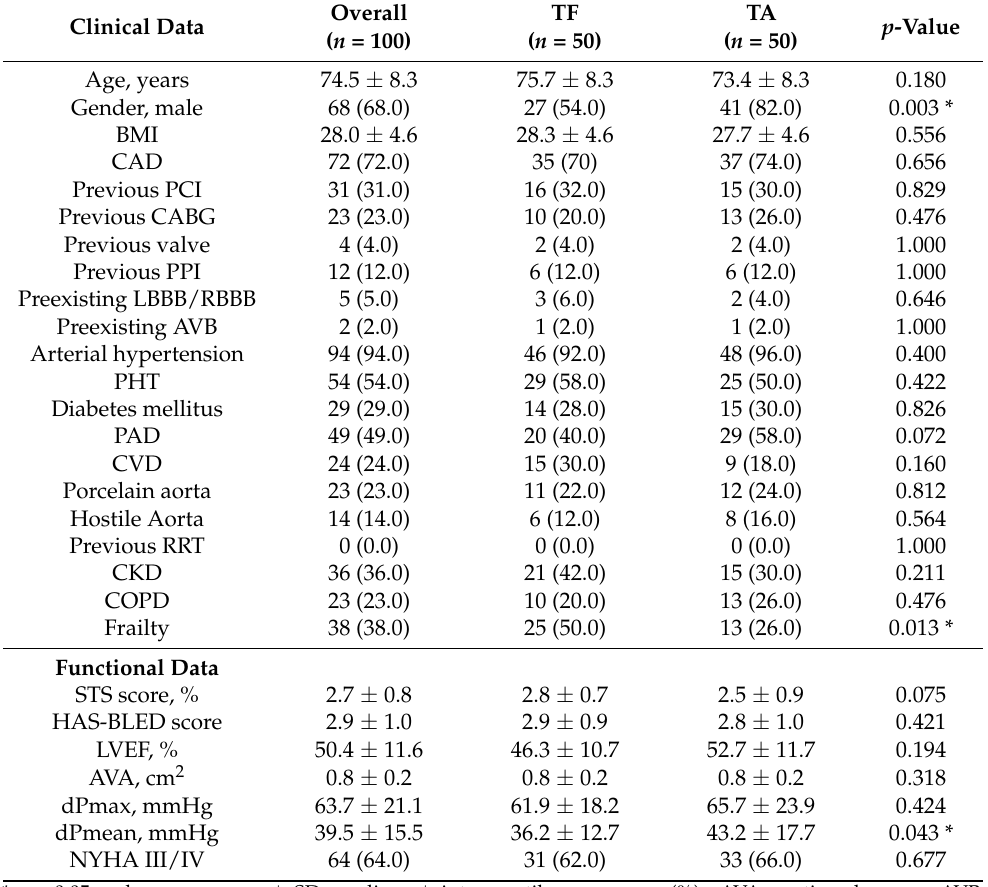
Table 1. Patient clinical and functional characteristics (propensity score-matched